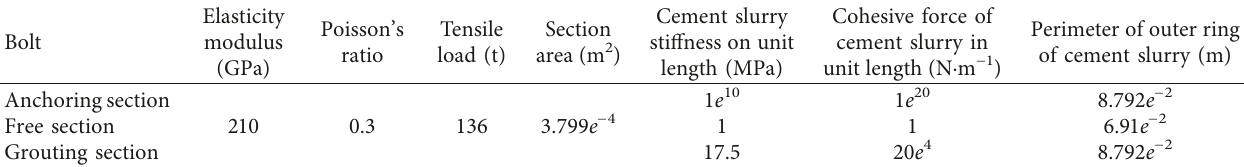
Table 3: Mechanical parameters of bolt.